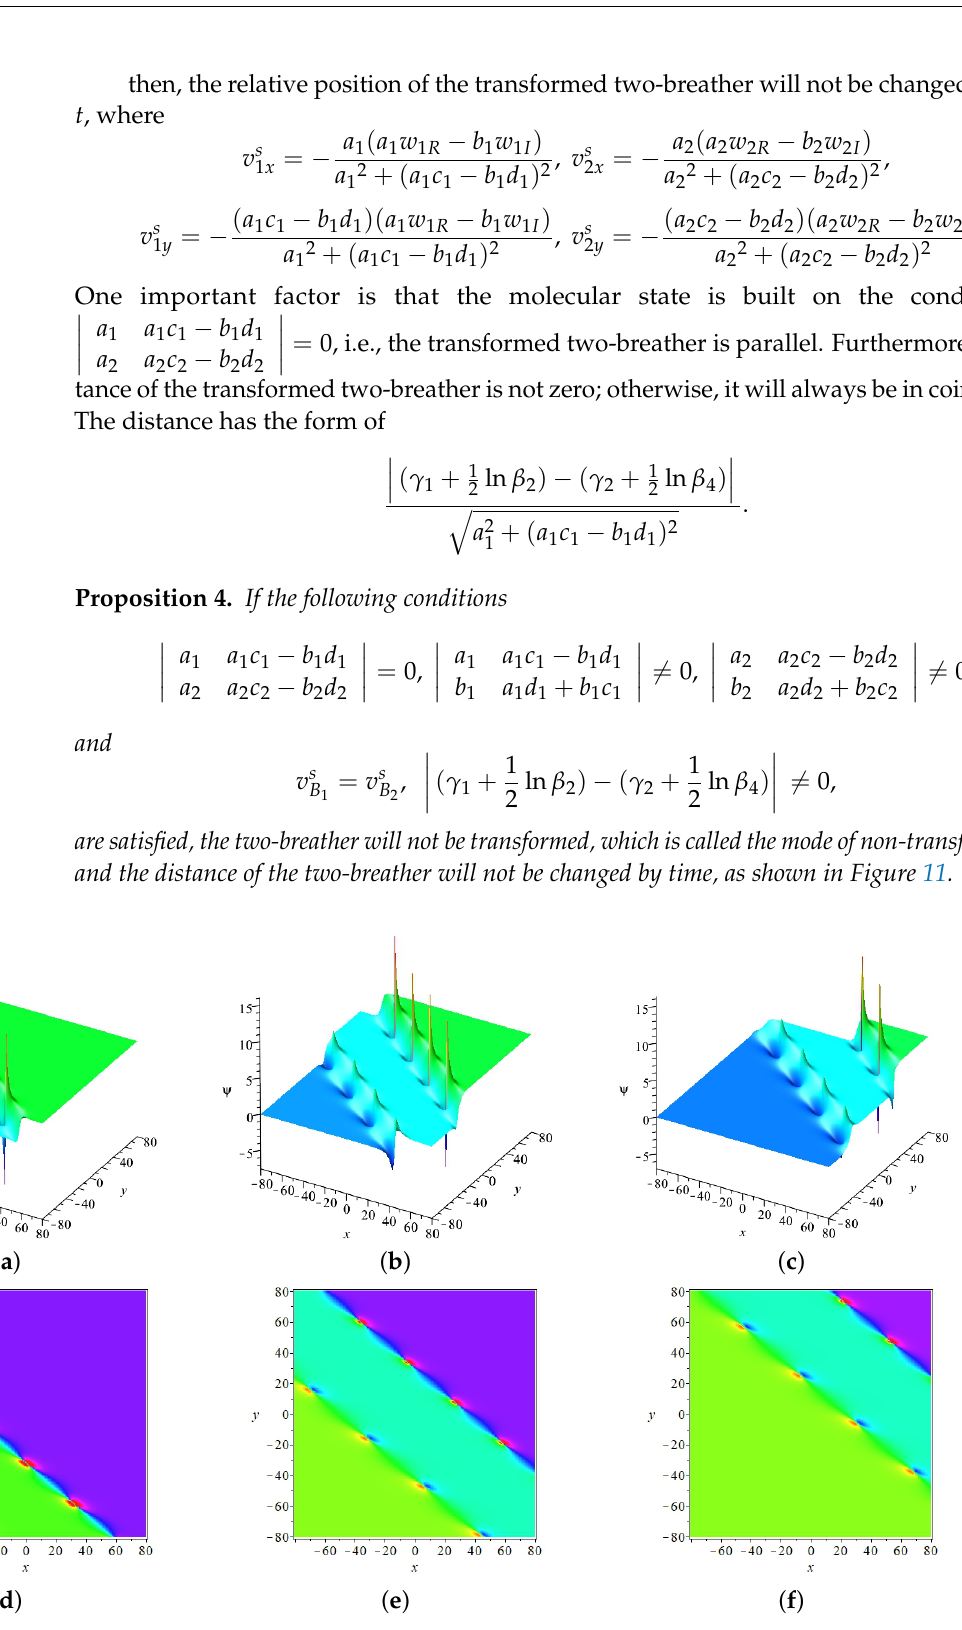
Figure 11. (Color online) The molecular state between breather and breather with r 2 = r 3 = r 4 = r 6 = r 7 = r 8 = 1, β 1 = β 3 = 2, κ 1 = κ 2 = 0, a 1 = 0.3, b 1 = 0, c 1 = 1.2, d 1 = 0.8, e 1 = 1, f 1 = 2.279, γ 1 = − 10, a 2 = 0.2, b 2 = 0, c 2 = 1.2, d 2 = 1, e 2 = 2 t = − 30, t = 0 and t = 30. ( d – f ) are contour